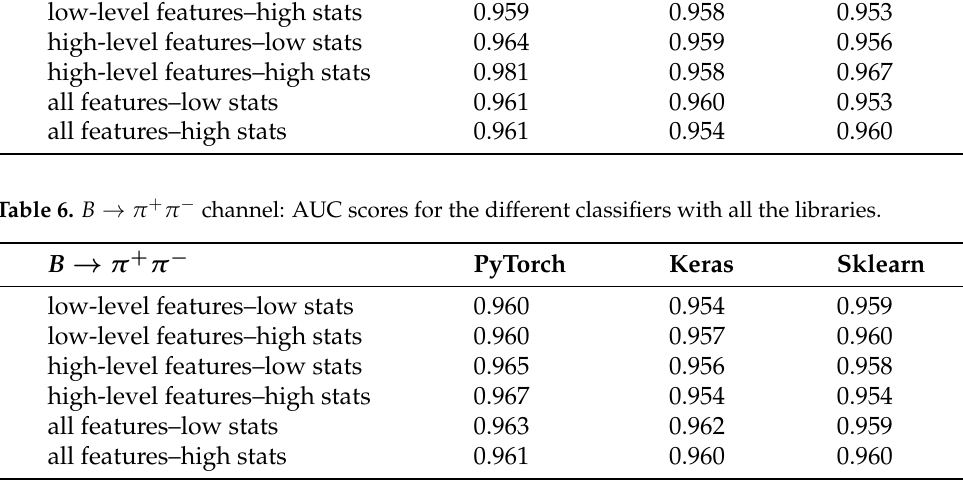
Table 7. B 3 π channel: AUC scores for the different classifiers with all the libraries. → B → 3 π PyTorch Keras